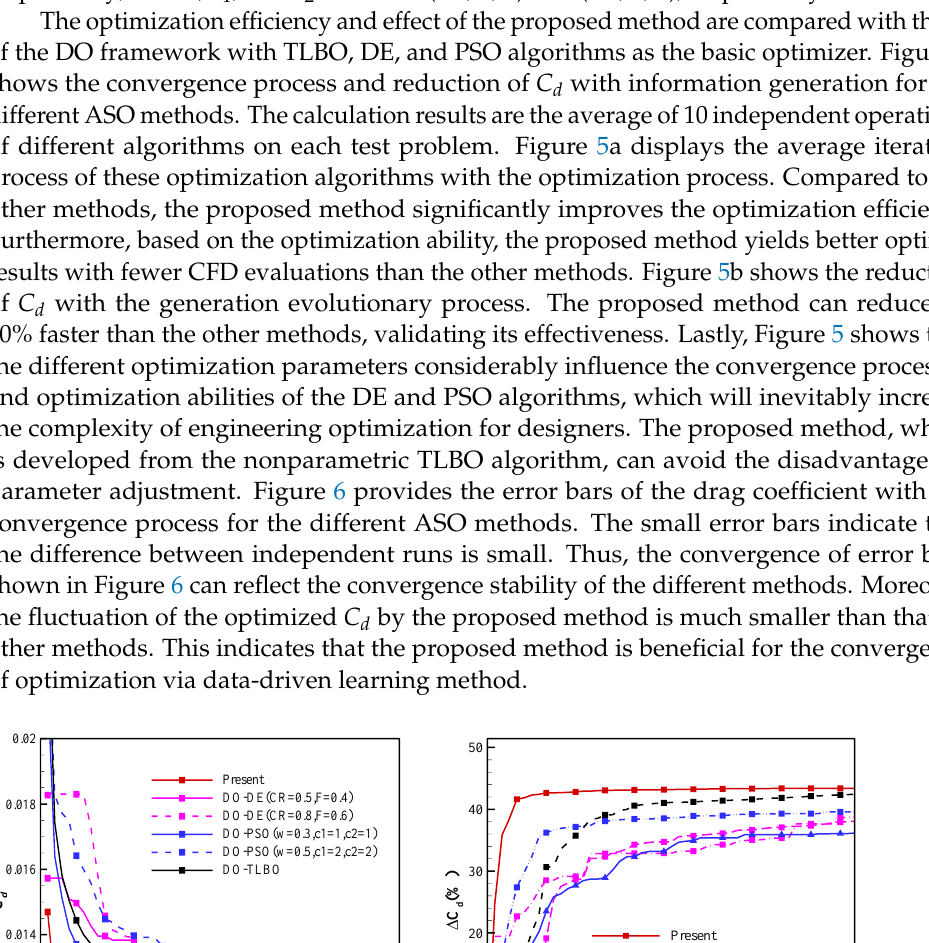
( b ) ( c ) Figure 6. Error bar of the drag coefficient ( C d ) with the convergence process. ( a ) Present (DDSAO- TLBO) vs. DO-TLBO; ( b ) Present vs. DO-DE; ( c ) Present vs. DO-PSO. Additionally, the C p contour with the optimization process should be analyzed. We compare the C p contour of the optimal airfoil at generations of 5, 10, 20, 30, and 40. Figure 7 shows the variation of the C p contour with increasing generation by different methods. The proposed method reduces the shock intensity faster than the other methods. Further- more, the shock intensity of the proposed method at G = 5 is even smaller than that of other methods at G = 40. The C p contour changes show that different parameter settings significantly affect the optimization results of the DE and PSO algorithms, reflecting the benefits of the nonparameter adjustment of the TLBO algorithm. Figure 8 shows the com- parisons of C p and airfoil shapes with the optimized airfoils. The optimized airfoil shape and corresponding C p by the present method at G = 5 are compared with those by other SAO methods at G = 40. The shock wave intensity of the optimized airfoil by the present method is obviously smaller than that by other methods. Moreover, the location of the